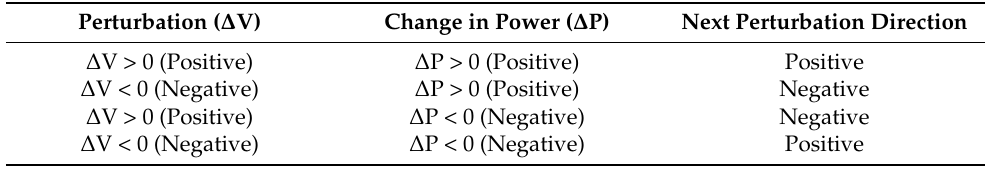
Table 2. Perturb and observe